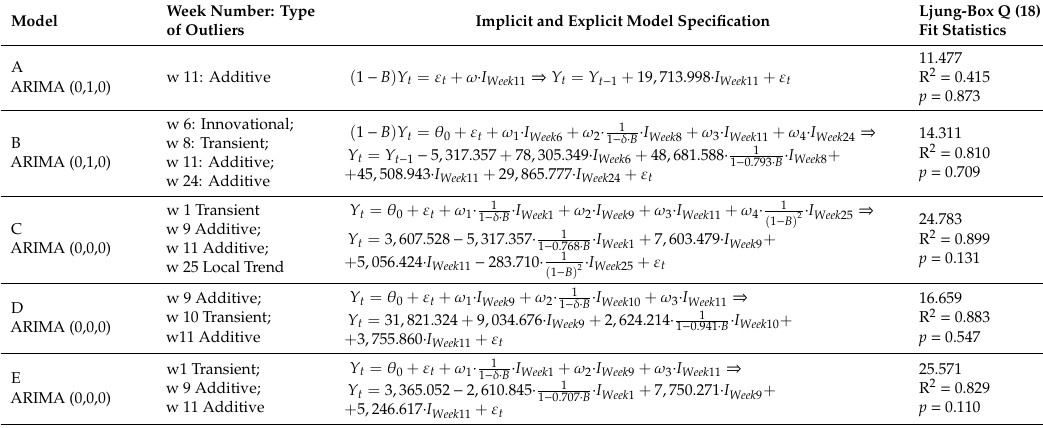
Table 2. Statistical parameters of the Autoregressive Integrated Moving Average (ARIMA) models of number of refugees’ arrivals in Serbia (Model A) and in the EU (Model B), registered in healthcare institutions (Model C), their medical conditions (Model D), and health care services used (Model E) during the Western Balkan Refugee Crisis 2015 /